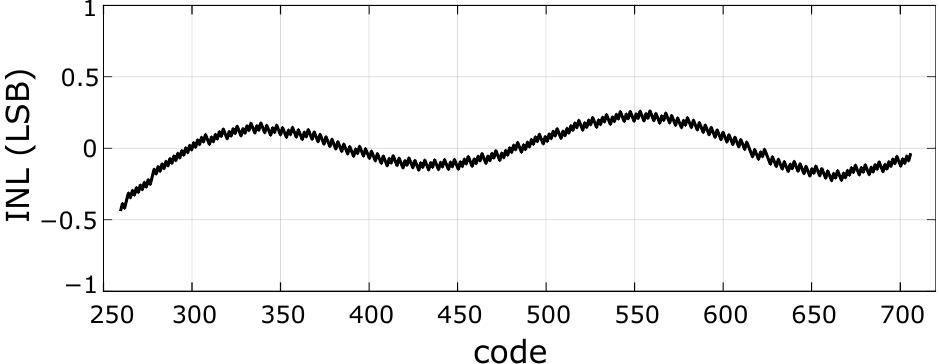
Figure 9. INL performance of the system with the circuit proposed in Figure